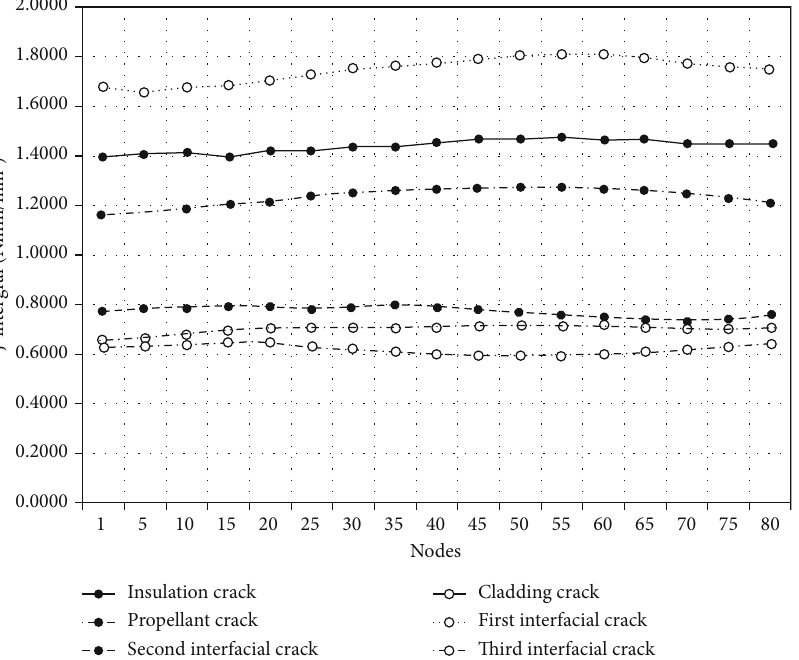
Figure 6: The J -integral of cracks and interfacial crack